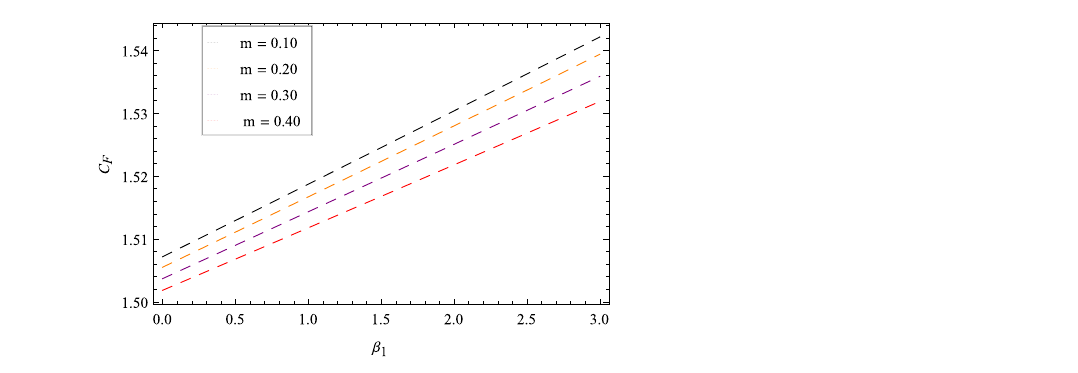
Figure 25. Pattern of graph curves on account of m